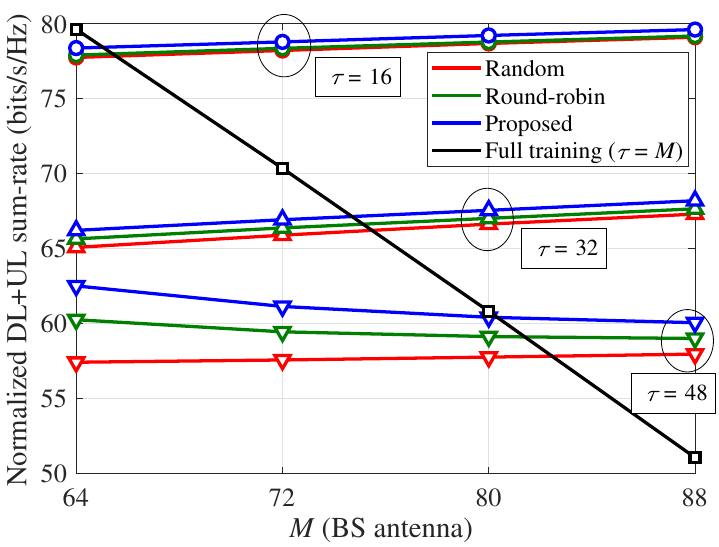
Figure 11. Normalized DL and UL sum-rate ( η sum ) per channel use according to the BS antenna ( M ): K u = 8, α = 70 dB, κ ij = 3, and 80 dB path loss between the BS and